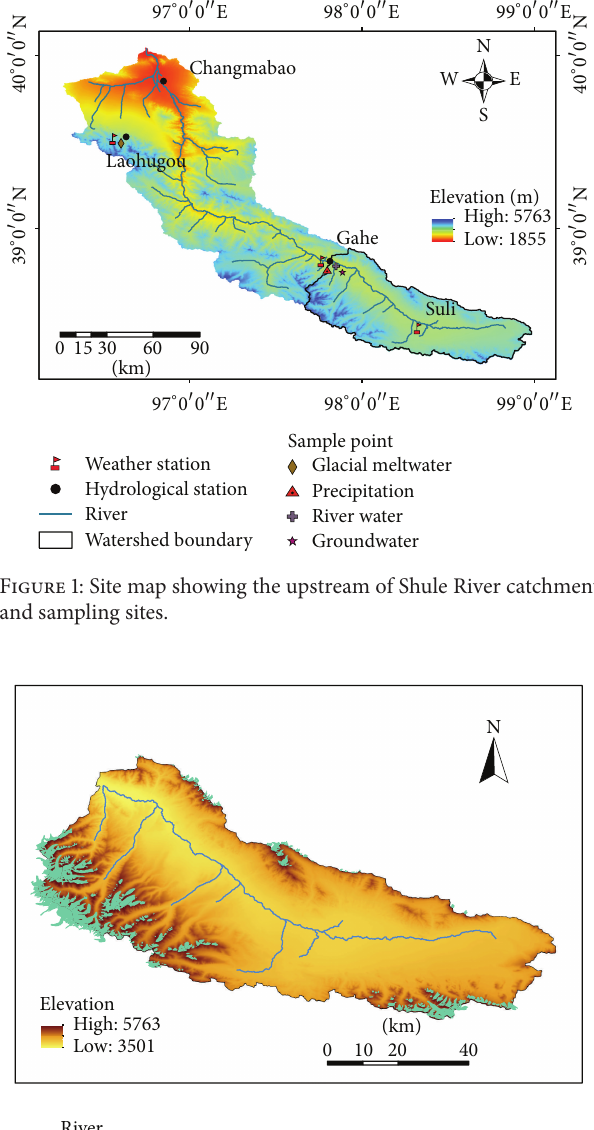
Figure 2: Glacier distribution of Gahe